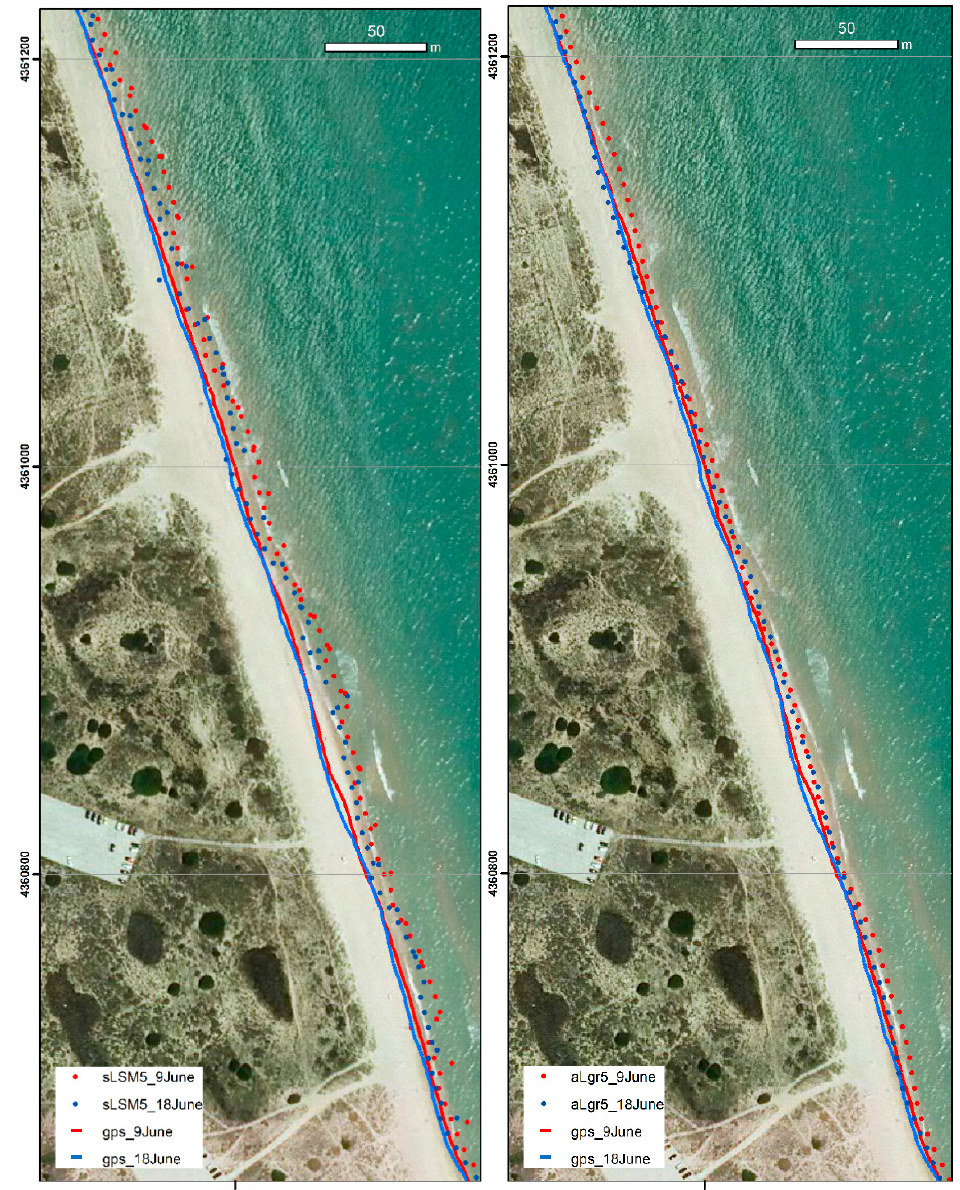
Figure 12. Coastal segment of El Saler beach where different shoreline solutions are shown for 9 and 18 June in red and blue respectively. The GPS shorelines are represented with lines and the sub-pixel shoreline solutions with dots (sLSM5 and the aLgr5). Solutions painted on an orthophoto taken from 2015 PNOA sources. The grid coordinates are GCS_ETRS89 UTM30N.